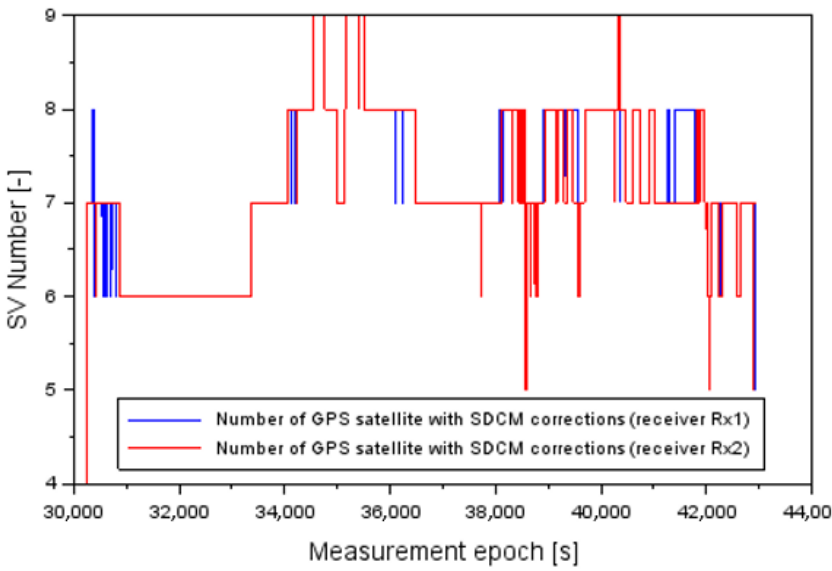
Figure 7. The number of GPS satellites with SDCM corrections for each receiver at flight test.